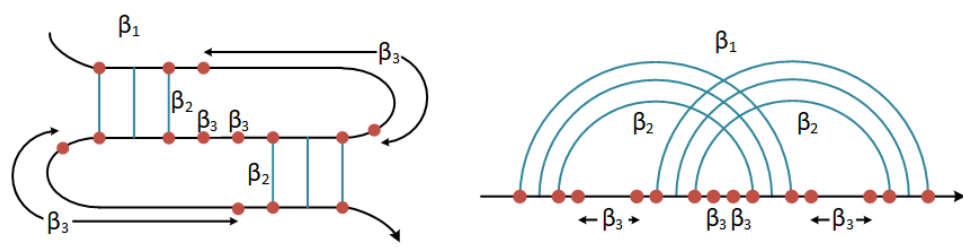
Figure 4. β 1 is the weight or cost of the existence of a pseudoknot; β 2 is the cost of the core stems; β 3 is the cost of the unpaired bases inside the pseudoknot (after